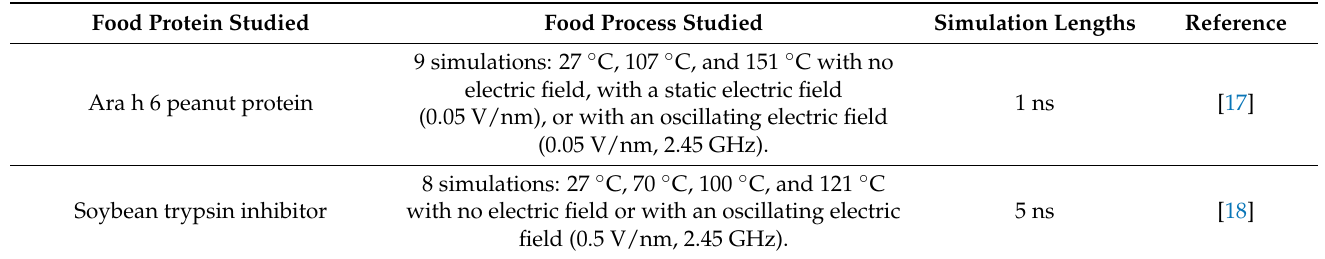
Table 1. Molecular dynamics studies using GROMACS applied to diverse food proteins. Food Protein Studied Food Process Studied Simulation Lengths